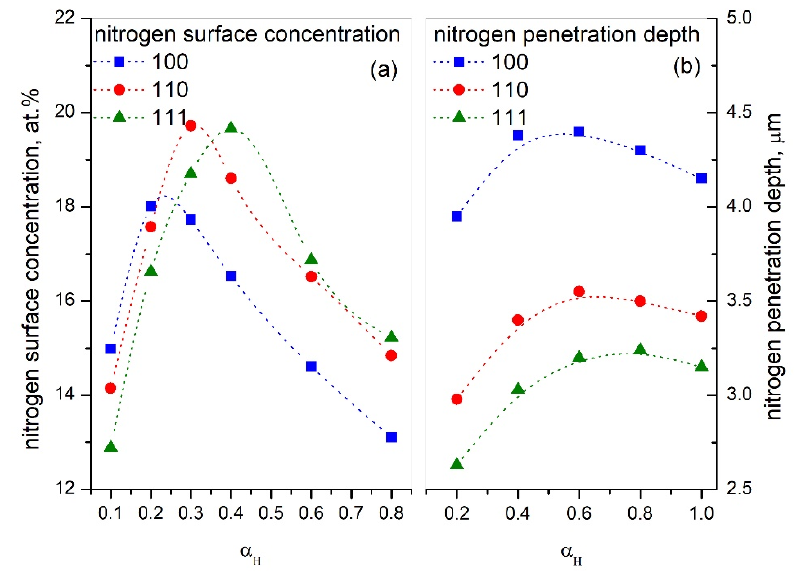
Figure 6. Nitrogen surface concentration ( a ) and nitrogen penetration depth ( b ) as functions of parameter α H for different crystallite orientations.